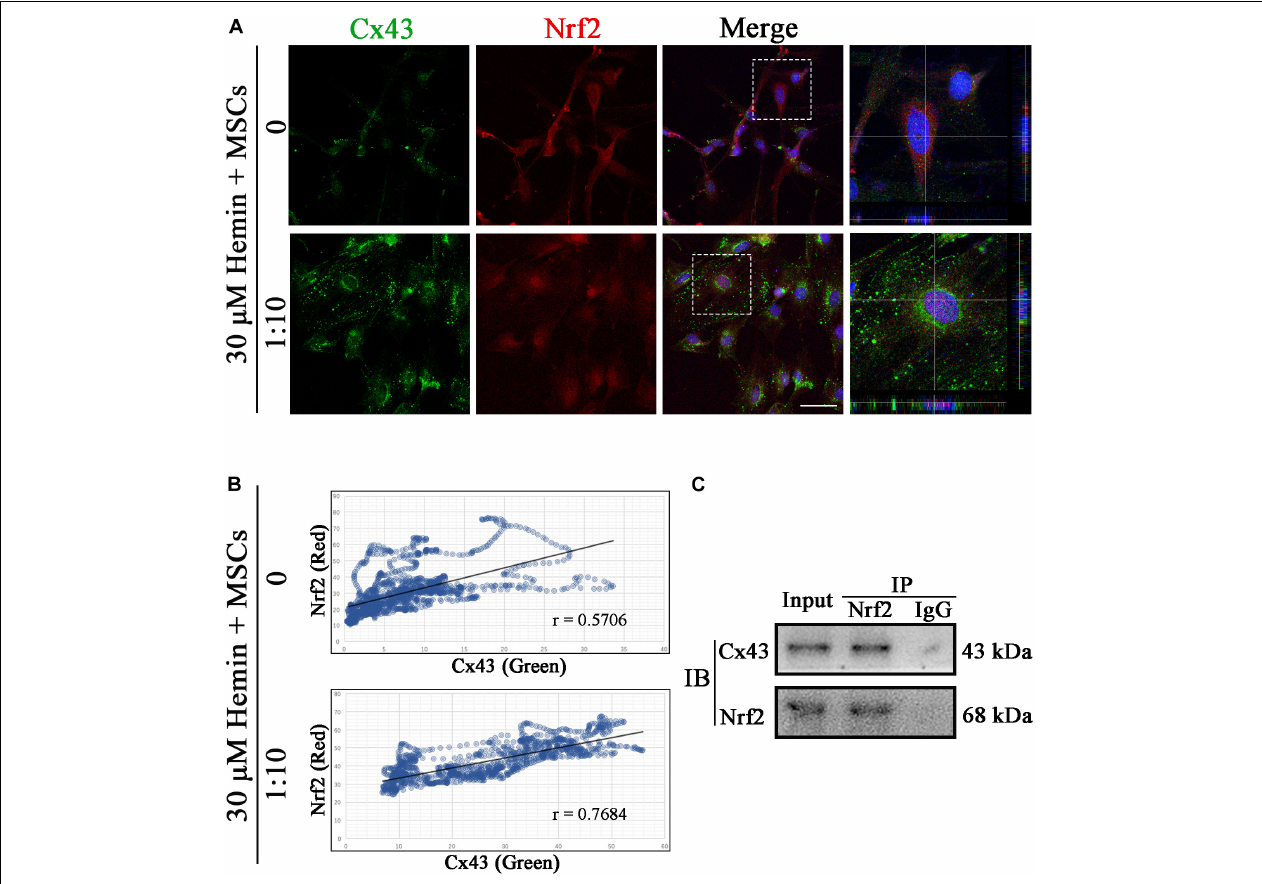
FIGURE 8 | Cx43 and Nrf2 were co-localized and physically associated. (A) Immunofluorescence double staining for Cx43 (green) and Nrf2 (red) in astrocytes exposed to 30 µ M hemin, with or without BM-MSCs coculture treatment. The cell nuclei were counterstained with DAPI (blue). Both proteins were co-localized at the cell–cell contact in untreated astrocytes, and Nrf2 was located in the cytoplasm at this time. After co-culture with BM-MSCs, the expression of Cx43 increased and Nrf2 accumulated in the nuclei. Bar = 25 µ m. (B) Pearson correlation analysis was used to check the relationship between Cx43 and Nrf2. In the scatter plot, the symbol r represented the Pearson’s correlation coefficient ( n = 3). (C) Western blotting analysis of Nrf2 immunoprecipitated samples using mouse anti-Cx43 monoclonal antibody. Cx43 was detected in the immunoprecipitated